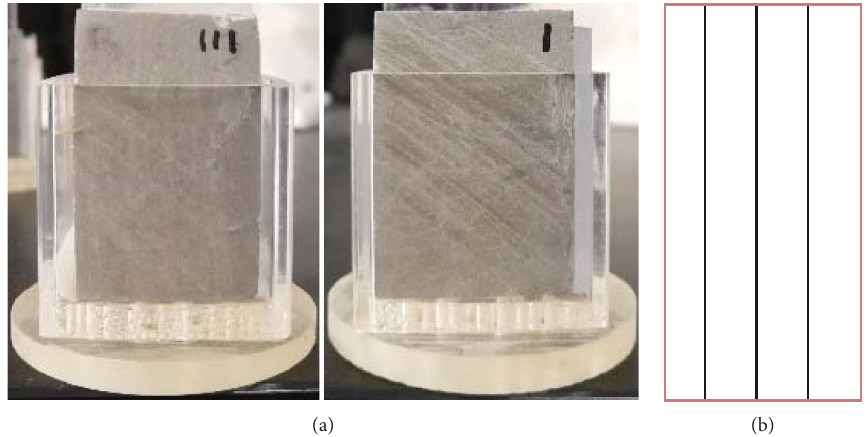
Figure 3: Sample preparation. (a) Samples in tubes for water imbibition; (b) joint direction of samples 3# and 1#.